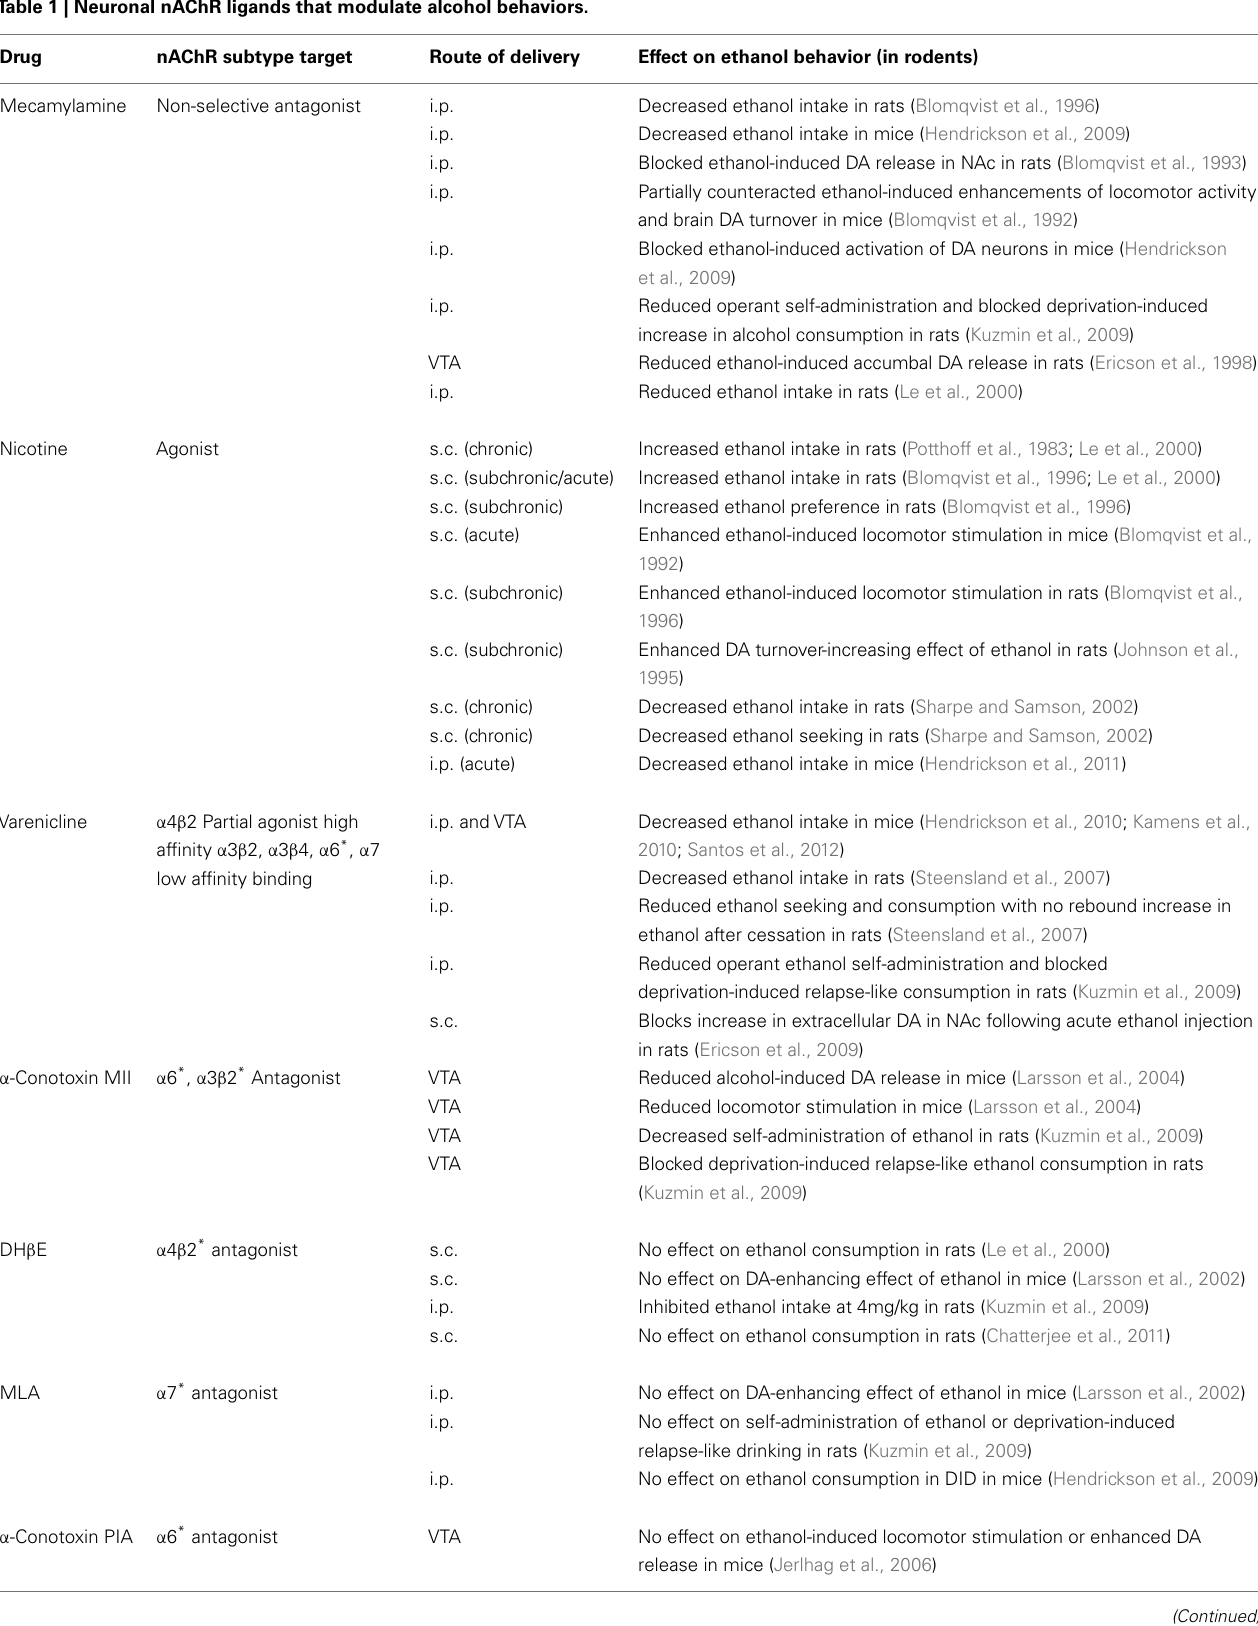
Table 1 | Neuronal nAChR ligands that modulate alcohol